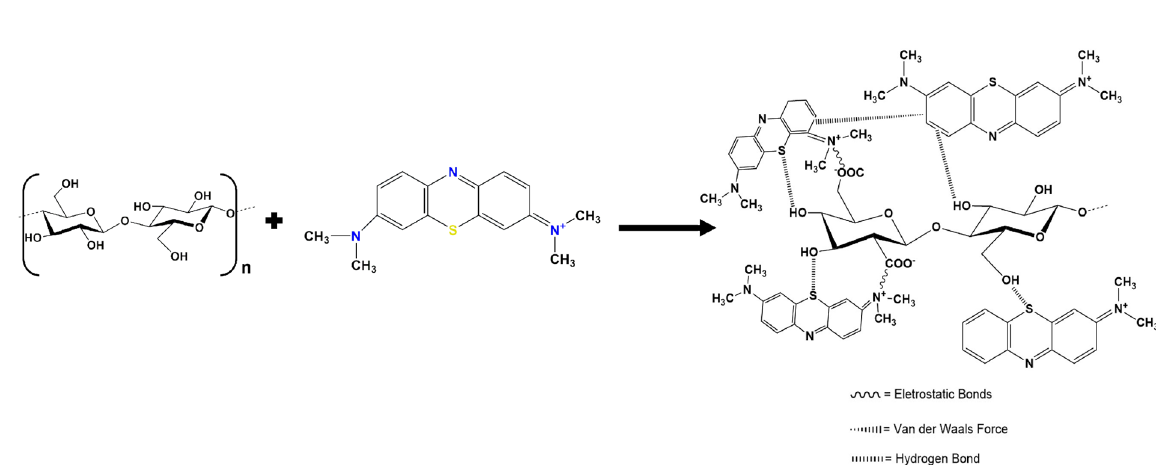
Figure 7. Predicted mechanism reaction between methylene blue and cellulose.